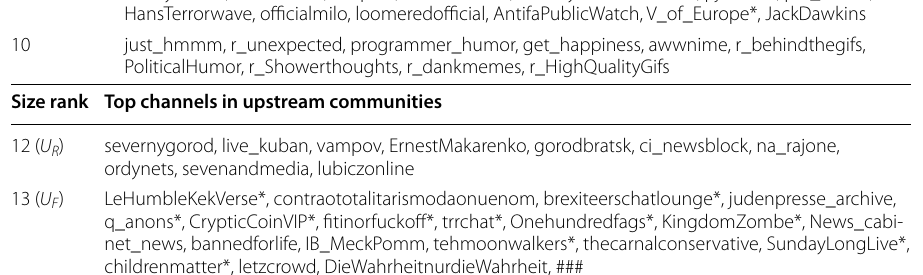
We give the top channels ranked by their in‑Katz centrality for channels in the downstream and core clusters and ranked by their out‑Katz centrality in the upstream clusters. We show the top 20 channels, sorted according to their Katz score, in communities linked to the UK and US far‑right and the top 10 channels in other communities. Channels marked with an asterisk correspond to group chats while the other ones correspond to broadcast channels